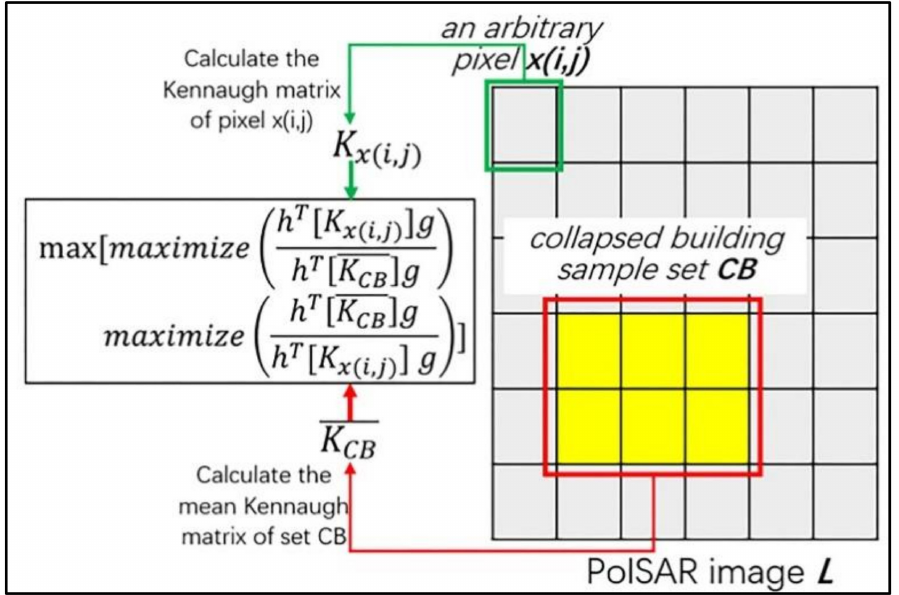
Figure 19. The schematic diagram of the OPCE matching